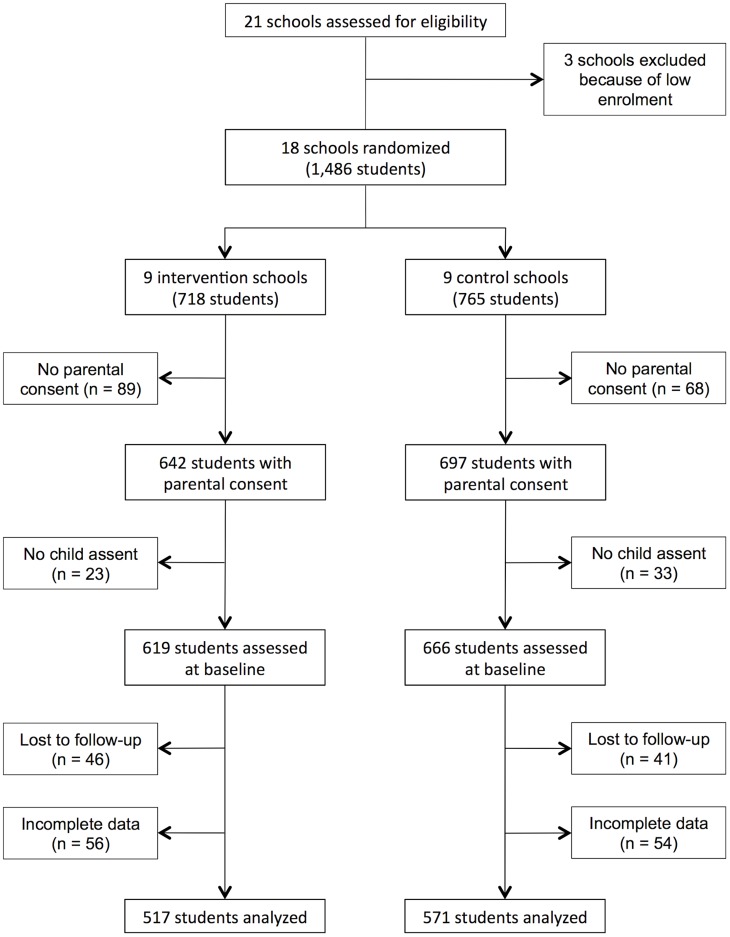
Trial flow diagram.